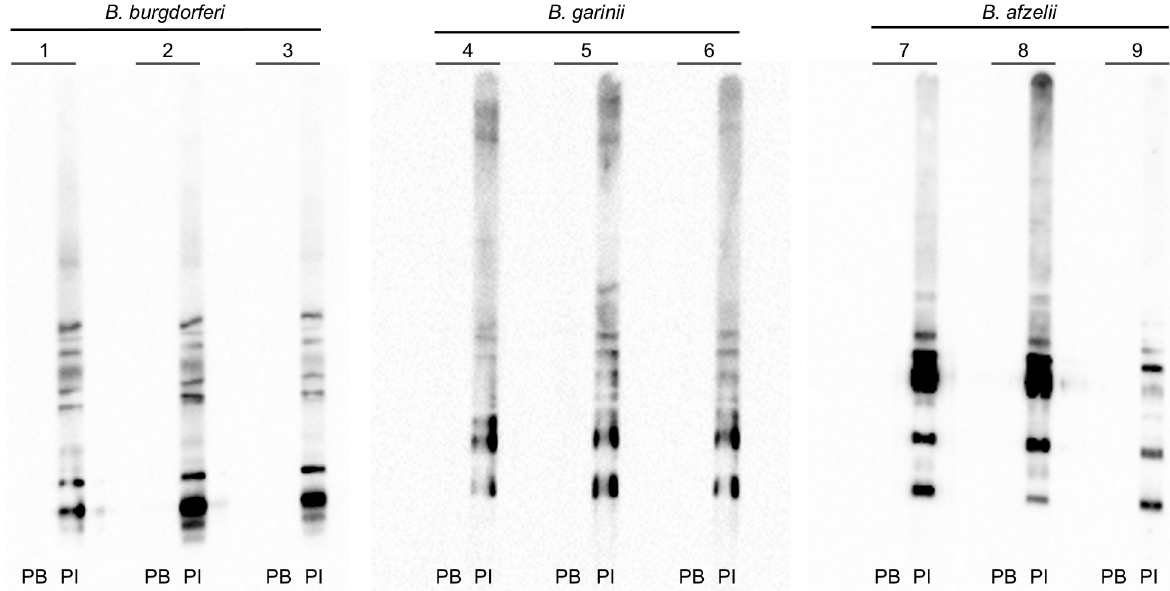
Fig 5. Immunoblot of B . burgdorferi B31-A3, B . garinii CIP 103362 and B . afzelii BO23 strains incubated with mouse sera. Borrelia strains were grown in BSK-II to mid-log phase and cell lysates were analyzed by immunoblotting. Cell lysates were incubated with serum obtained from mice either before (Pre-bleed, PB) or 6 weeks after needle inoculation (Post-infection, PI) with B . burgdorferi (lanes 1 to 3), B . garinii (lanes 4 to 6) and B . afzelii (lanes 7 to